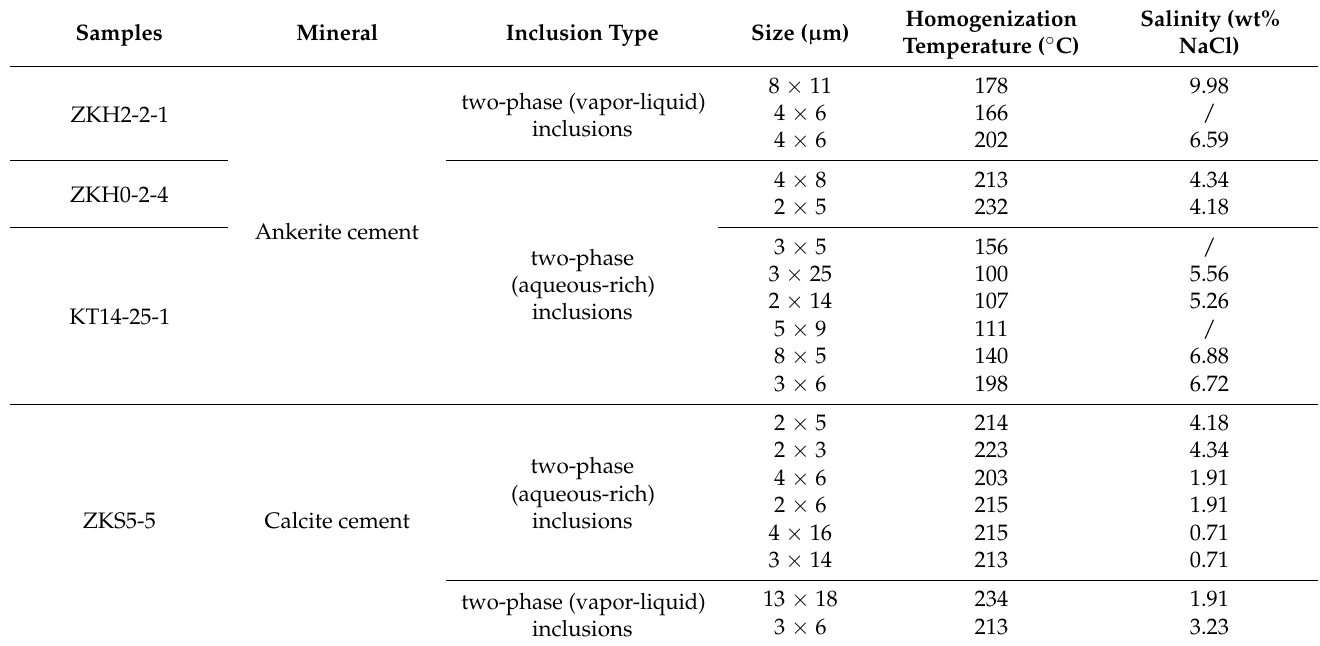
Table 4. S isotopic compositions of pyrite from the Lower member of Yaojia Formation. /: Not